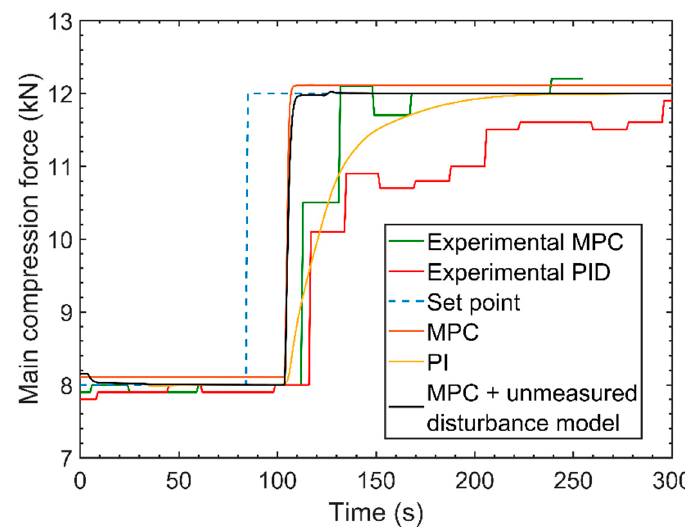
Figure 10. Simulated and actual closed loop results compared using a step change. Table 5. Closed loop performance metrics.